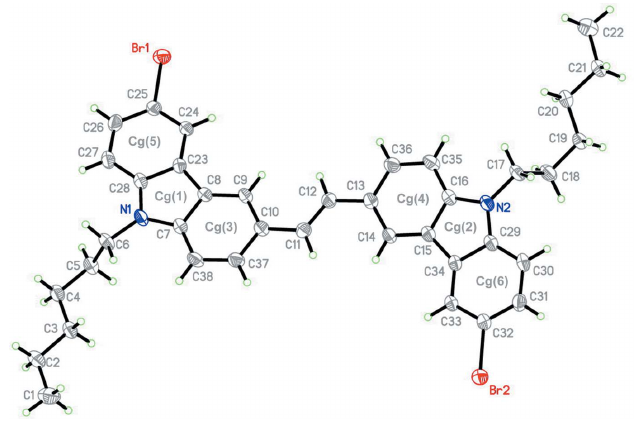
(Table 1) between neighboring molecules along the a axis